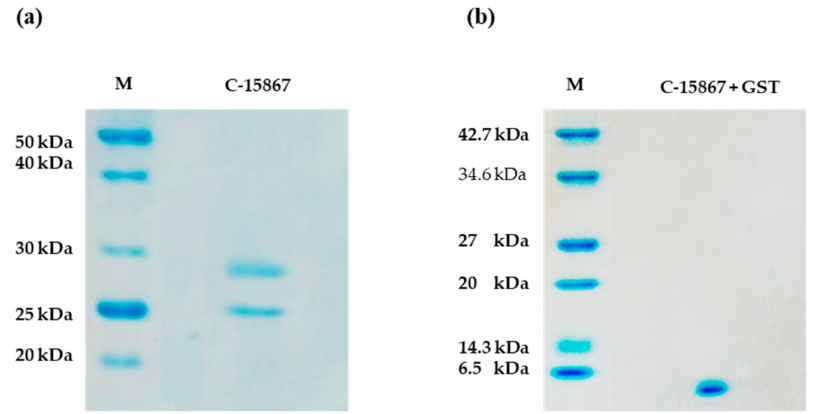
Figure 3. ( a ) SDS-PAGE of the purified recombinant GST-peptide fusion product (2 µ g). The band at about 29 kDa corresponds to the expected product while the band at about 25 kDa represents free GST. The amount of GST-peptide fusion product is equal to 3.2 mg per liter of culture. ( b ) SDS-PAGE (12.5%) of recombinant C-15867 after cleavage with thrombin (2 µ g). The peptide yield is 1.8 mg per liter of